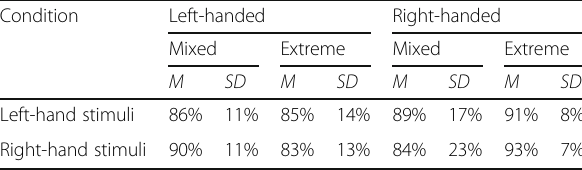
Table 1 Descriptive statistics for accuracy of same-hand